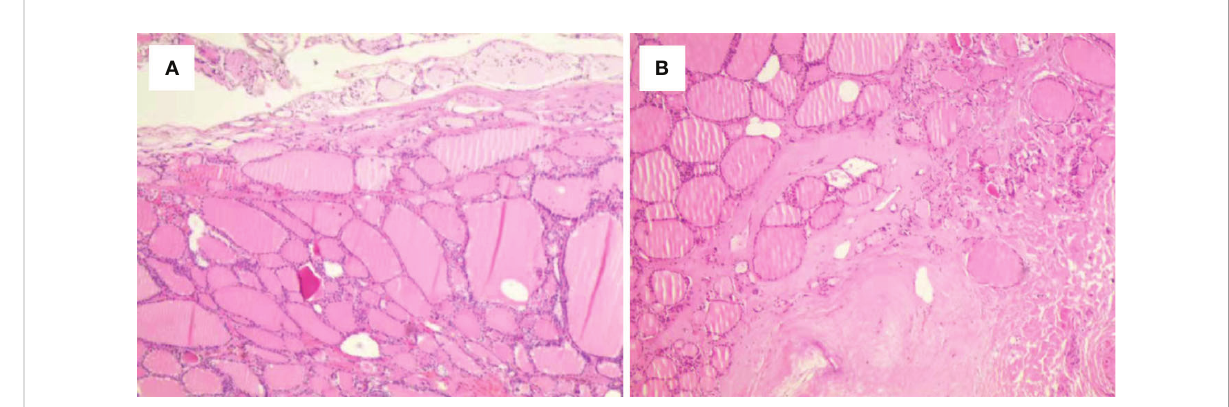
FIGURE 2 Histological outcomes of the post-ablation lesions in multifocal micro-PTC (case 3). (A, B) Nodular goiter was found in the post-ablation zone of the left (A) and right (B) thyroid